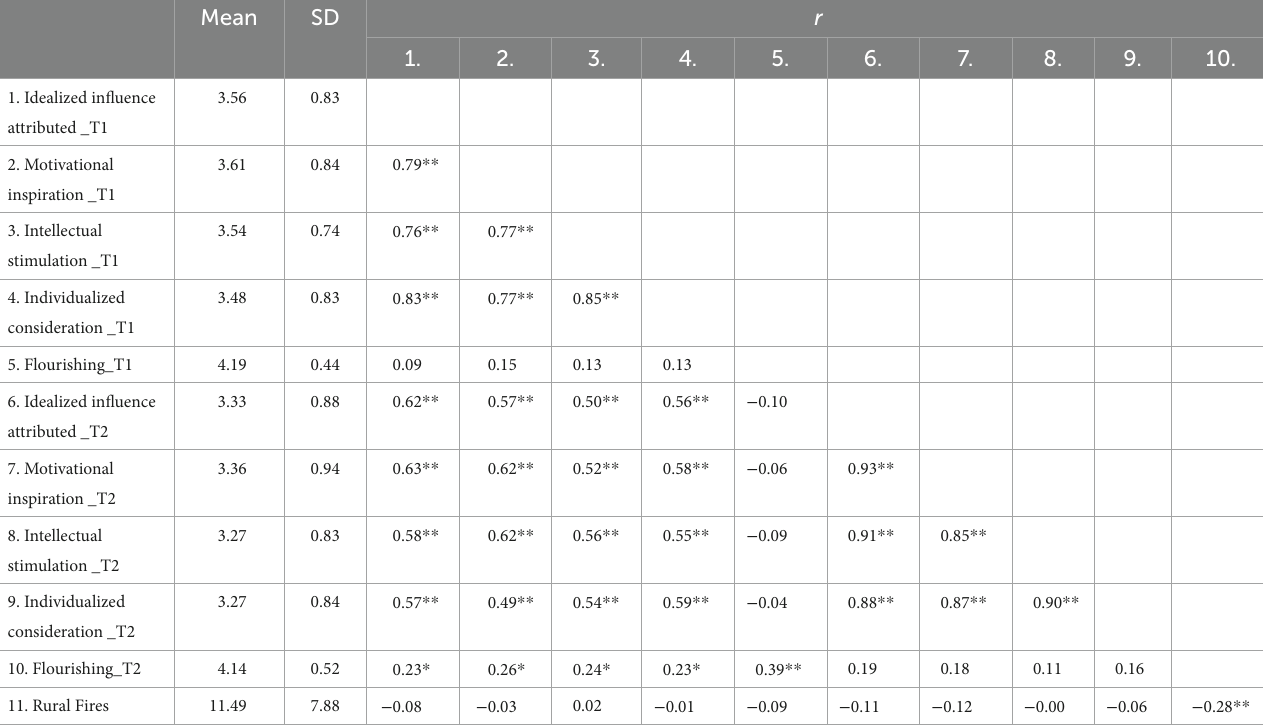
TABLE 1 Mean, SD, and Correlations ( r ) between the variables under study.